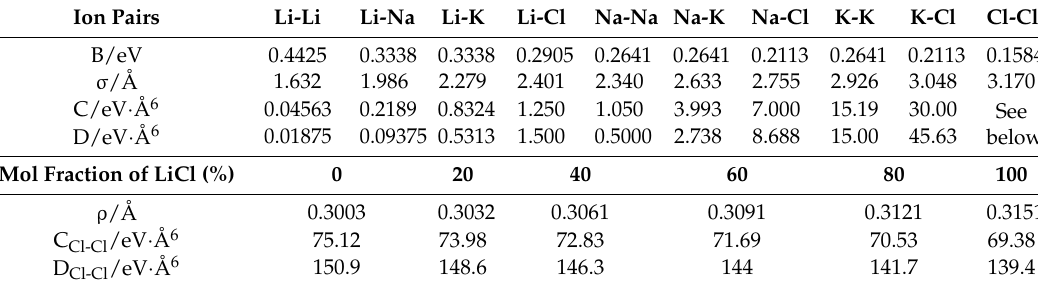
Table 1. Potential parameters for different pairs in the ternary systems.